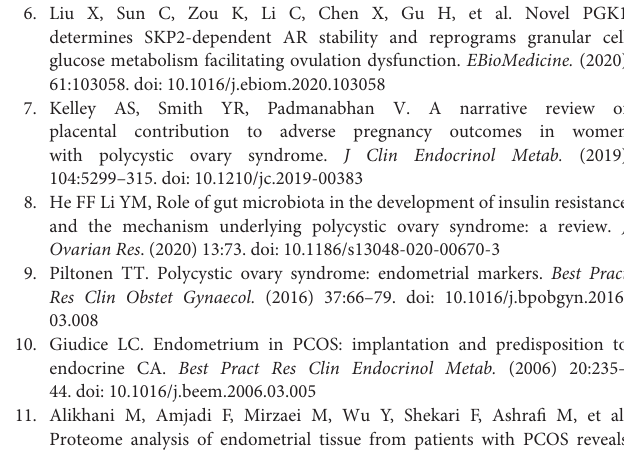
Supplementary Figure 1 | Determination of β -sitosterol in Bu Shen Yang Xue formula by liquid chromatography-tandem mass